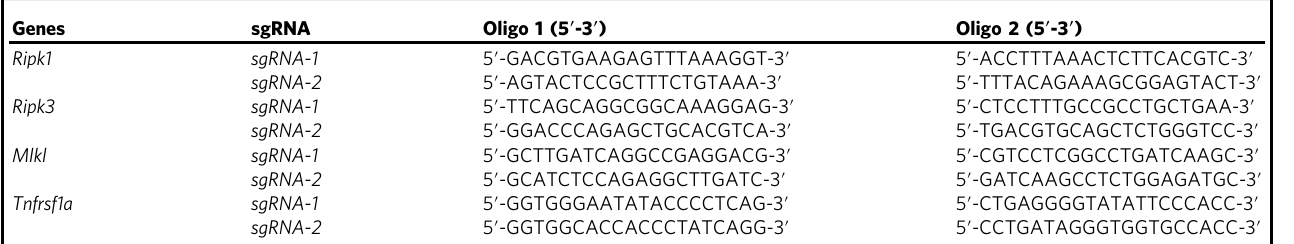
Fig. 2 SSL10 triggers RIPK3-dependent necroptosis of HEK293T and HUVEC cells. a HEK293T and HUVEC cells were pretreated with 50 μ M Nec-1s or 50 μ M GSK ’ 872 for 30 min and then stimulated with 2 μ M SSL10 for 48 h at 37 °C and 5% CO 2 . The release of LDH was detected. b Ripk1 , Ripk3 , or Mlkl knockout (KO) HEK293T cells were treated with 2 μ M SSL10 for 48 h at 37 °C and 5% CO 2 , and the LDH release was detected. c Wild type (WT) or Ripk3 KO HUVEC were treated with 2 μ M SSL10 for 48 h at 37 °C and 5% CO 2 , and the LDH release was detected. d WT or Ripk3 KO HEK293T cells were treated with SSL10 for 48 h and the cell viability was measured by fl ow cytometry after Annexin V/PI staining. The dot plot (left) is representative of three independent experiments, and the results of quanti fi cation (right) are shown as a bar graph. e WT or Ripk3 KO HEK293T cells with or without transient complementation of Ripk3 were treated with 2 μ M SSL10 for 48 h at 37 °C and 5% CO 2 , and the LDH release was detected. Cells treated with 2 μ M SSL7 were used as a negative protein control throughout the experiments. All data are presented as the means ± SD calculated from three independent experiments. * p < 0.05; ** p < 0.01; *** p < 0.001 compared to the Ctrl cells (buffer-treated cells). # p < 0.05; ## p < 0.01; ### p < 0.001 compared to the SSL10 treated group, by one-way ( a and d ) or two-way ANOVA ( b , c , and e ). Table 1 Sequences of sgRNA for CRISPR-Cas9 genome